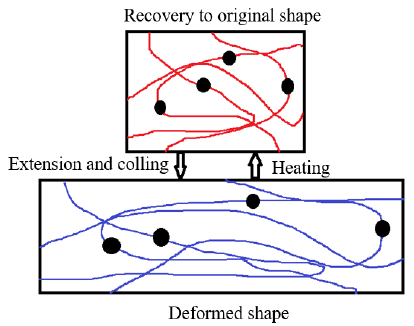
Figure 13. Shape memory thermally induced.